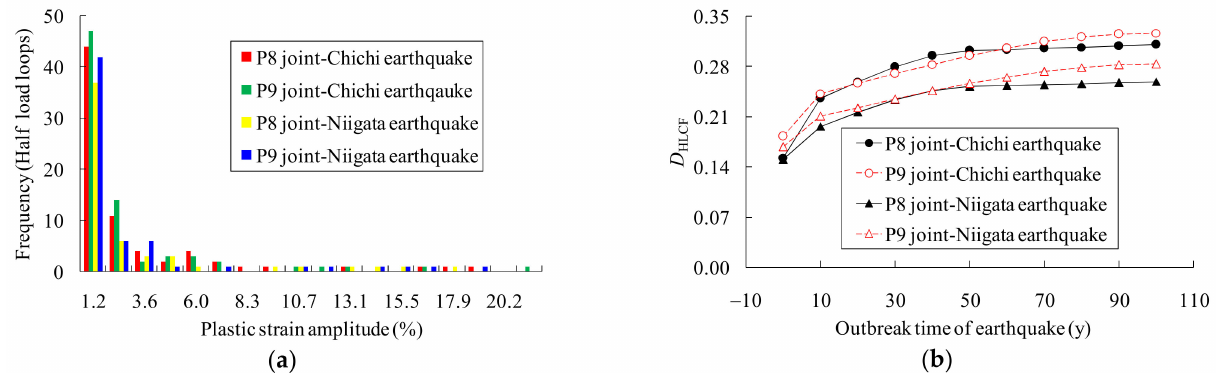
Figure 17. Plastic strain spectra and coupled fatigue damages of the joints: ( a ) plastic strain spectra of the joints; ( b ) HLCF damages of the